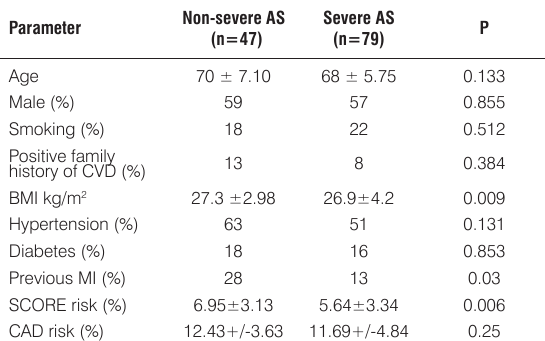
Table 1. Baseline characteristics of the studied population.